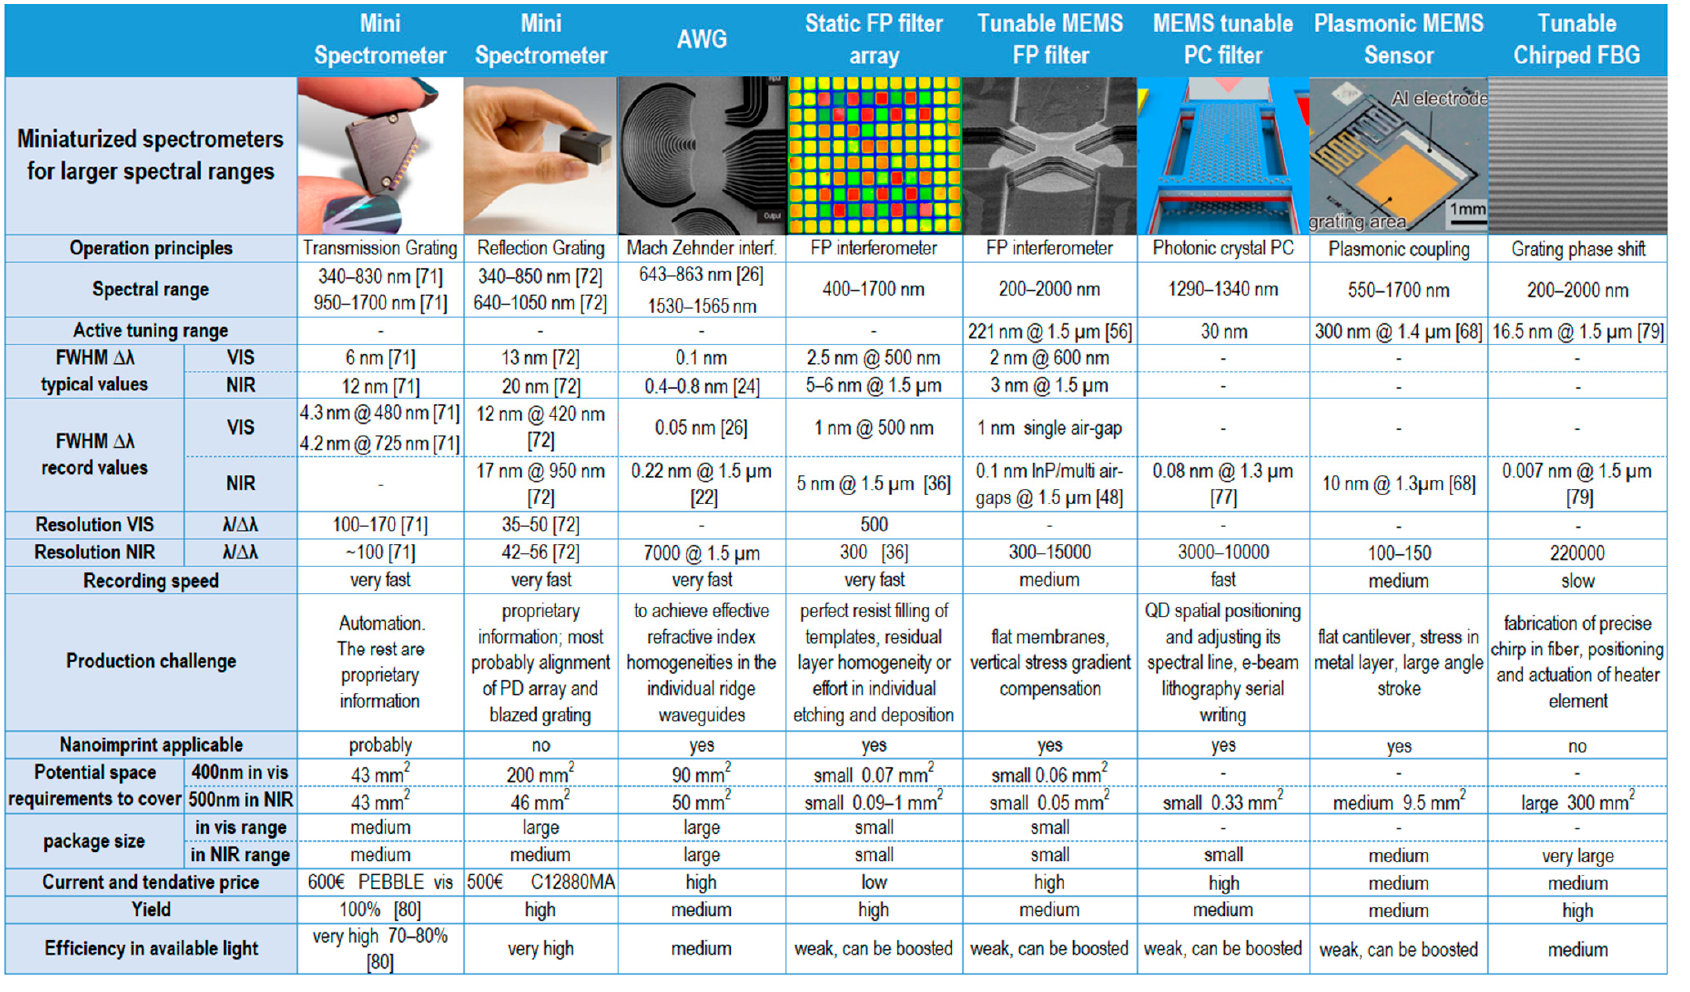
Figure 3. This review benchmarks different miniaturized optical sensors. The comparison concerns mainly optical properties, economic questions and manufacturing challenges. λ always denotes the vacuum wavelength. The abbreviations have the following meaning: arrayed waveguide grating (AWG), Fabry-Pérot (FP), micro-electro-mechanical system (MEMS), full width of half maximum (FWHM) and quantum dot (QD). References inside the table: transmission grating spectrometer [71,80], reflection grating spectrometer [72], AWG [22–24,26],